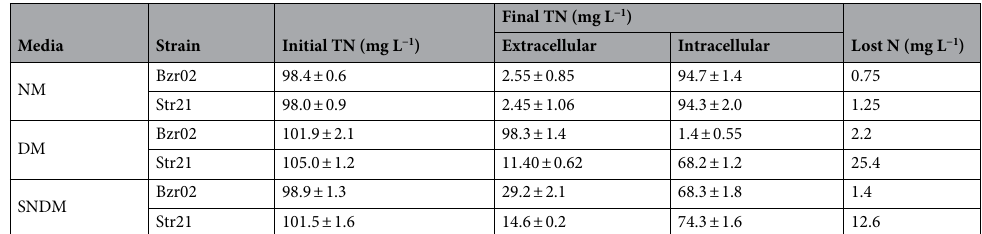
Table 3. Nitrogen balance of strains Bzr02 and Str21 during the nitrogen transformation. NM: nitrifying medium; DM: denitrifying medium; SNDM: simultaneous nitrifying-denitrifying medium. Values represent the mean and the standard error (n =